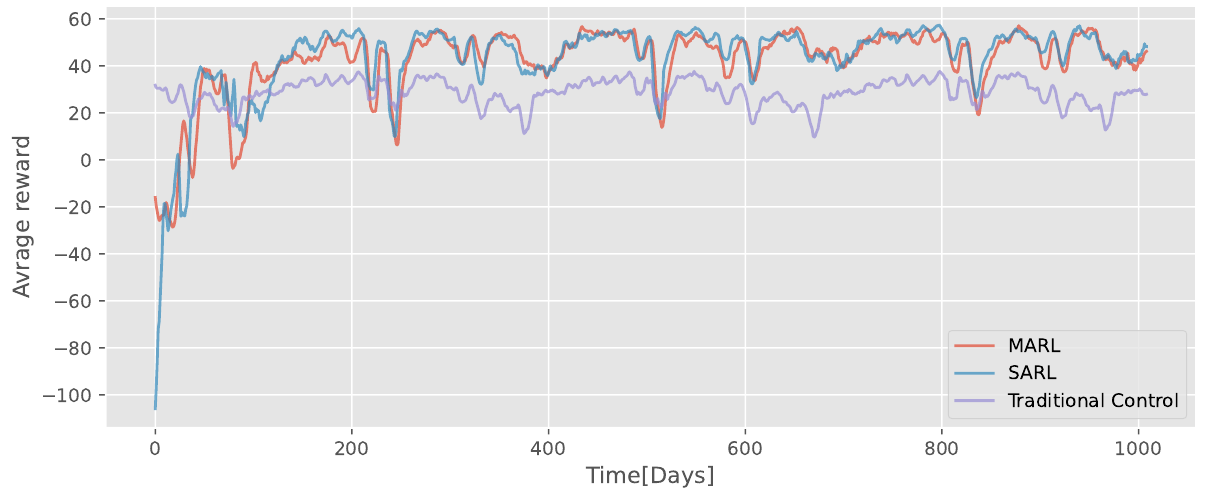
Figure 8. Reward signal of the one-zone UFH system. Simulation time is 1000 days.